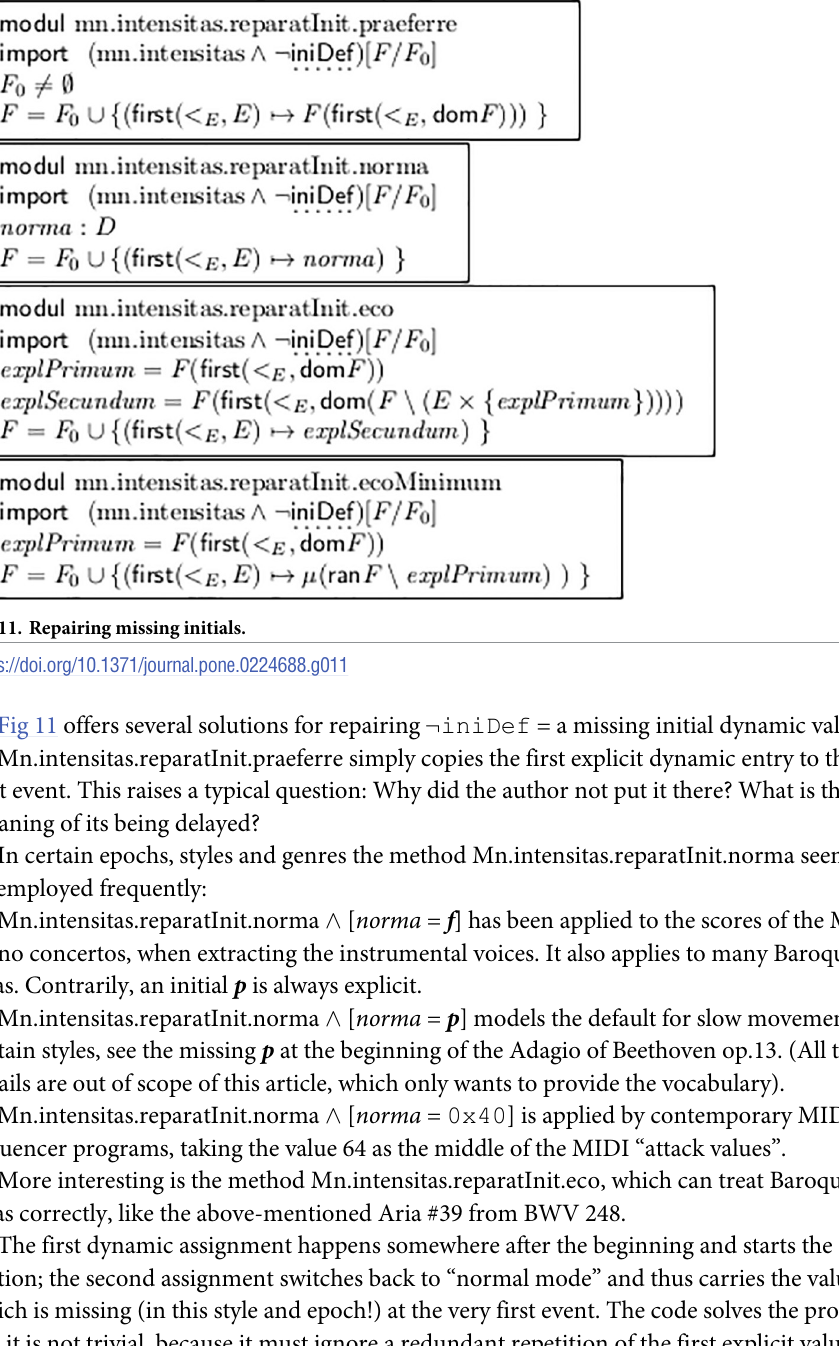
Fig 11 offers several solutions for repairing ¬iniDef = a missing initial dynamic value: